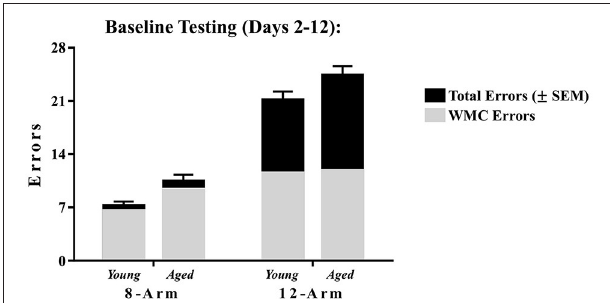
FIGURE 2 | WRAM performance represented as WMC errors and their contribution to Total errors. The proportion of Total errors ( ± SEM) comprised of WMC errors for both mazes across Acquisition and Asymptotic Phases of testing. For the 8-Arm WRAM, other than start arm errors, all errors must be WMC errors; however, in the 12-Arm WRAM, rats can make WMC errors, as well as RM and WMI errors. While the rats tested on the 8-Arm WRAM rarely made entries into the only arm without a platform i.e., the start arm, rats tested on the 12-Arm WRAM made a large number of unplatformed arm entries. This further demonstrates the separation of errors made when a reference memory component is added to the working memory portion of the